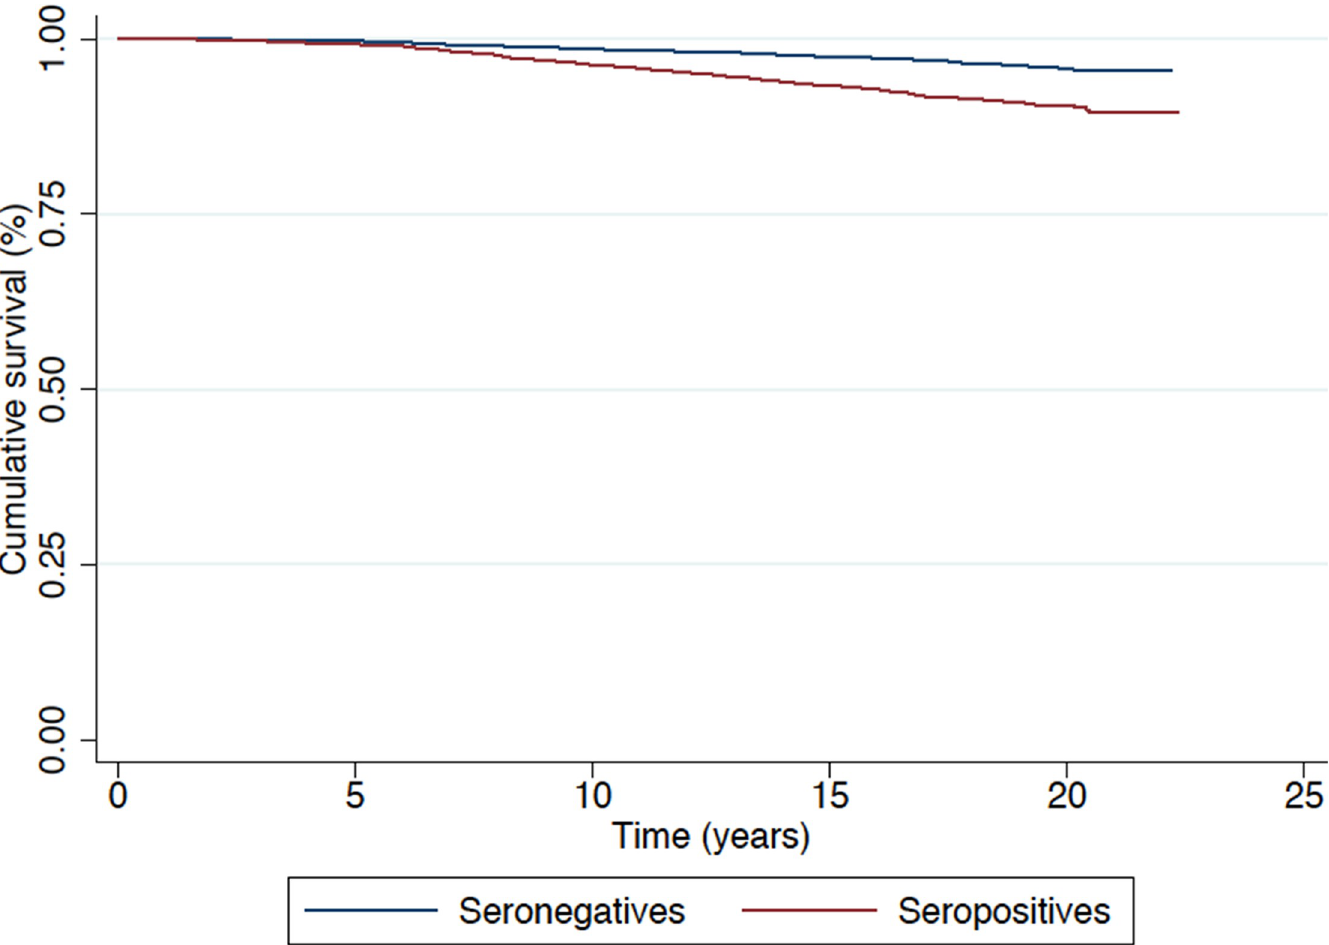
Fig 1. Survival (in years) by HCV serological status considering all causes of